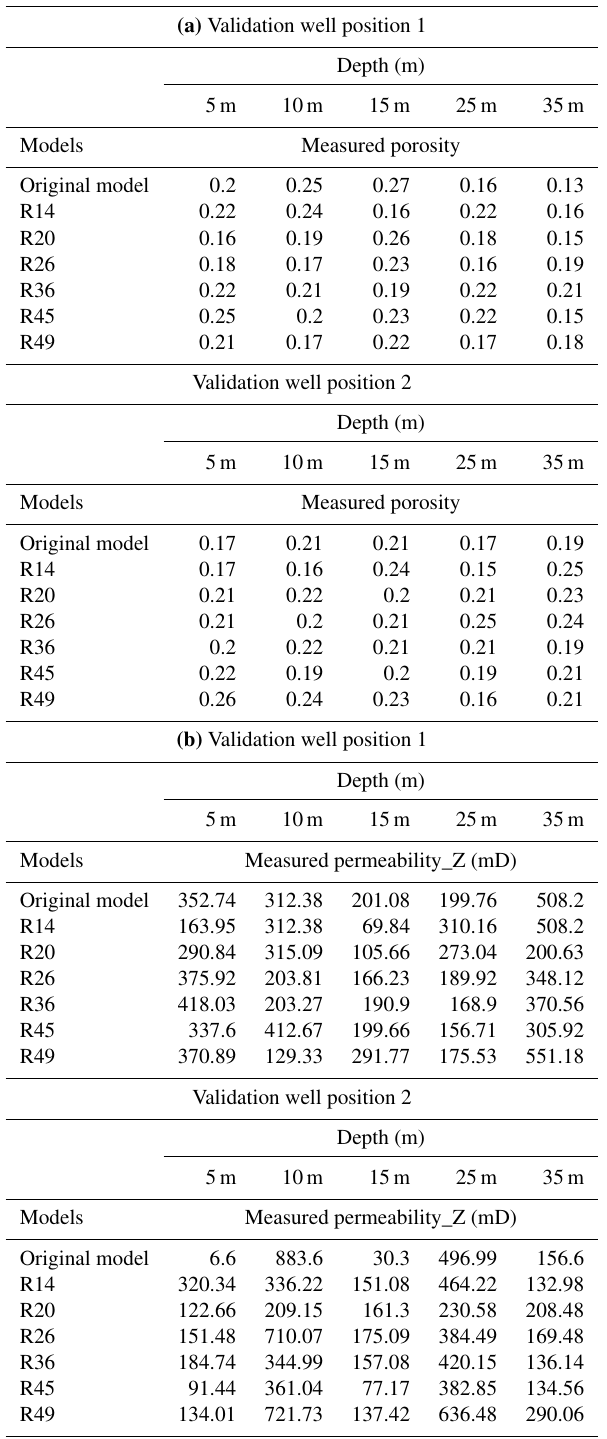
Table 5. A comparison of (a) porosity and (b) permeability esti- mates from selected intervals in the original porosity–permeability models and forward-modelling-based porosity and permeability